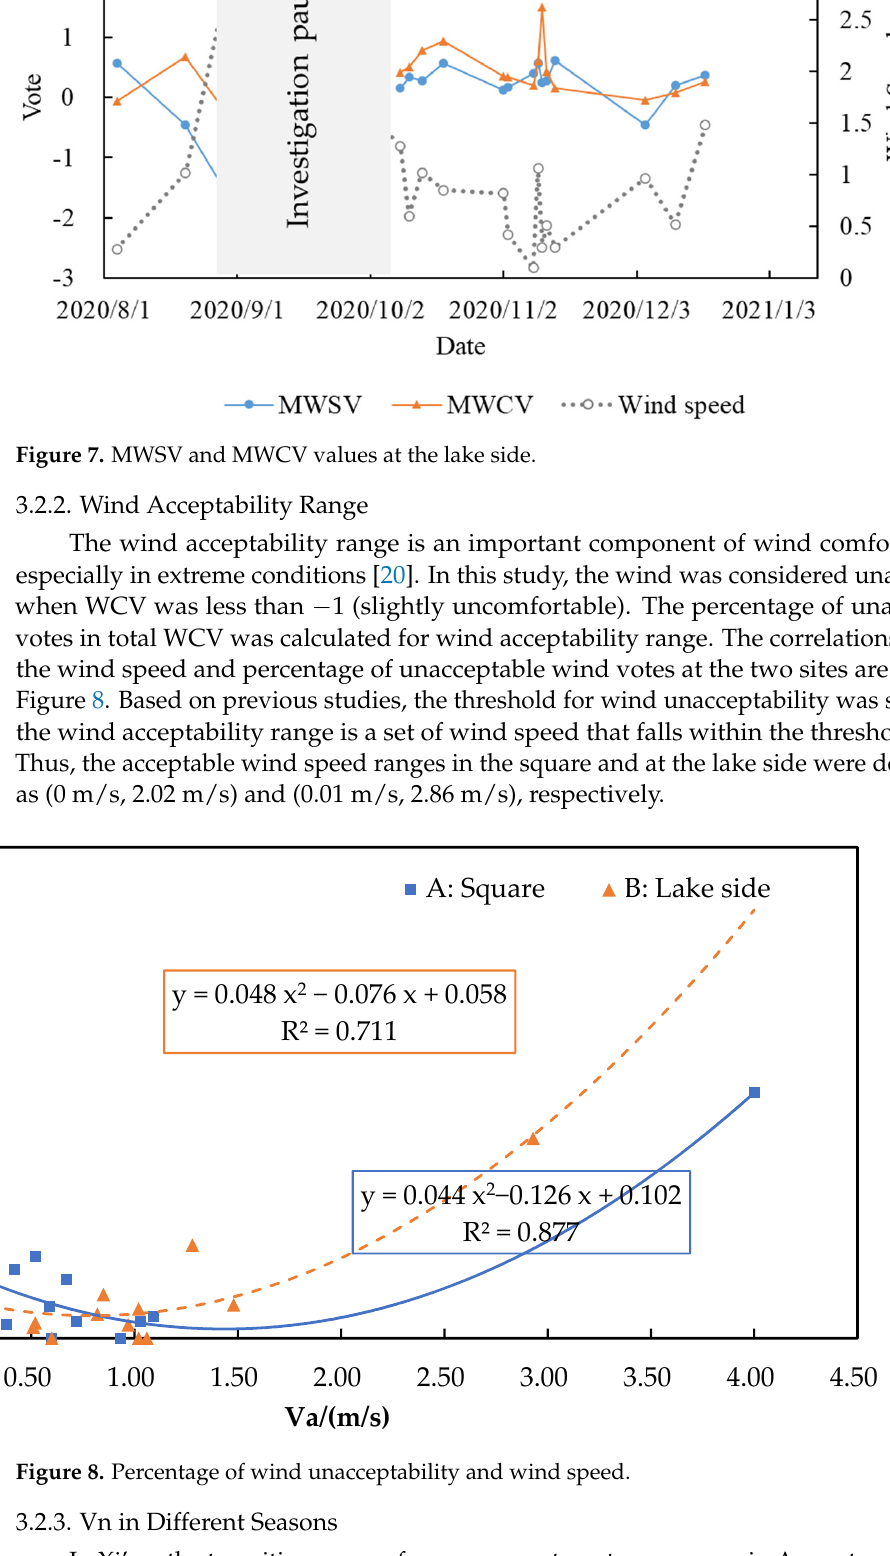
Figure 8. Percentage of wind unacceptability and wind speed.